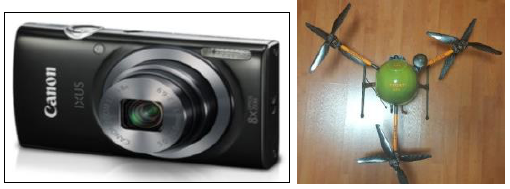
Figure 3. Air platform (hexacopter) and preferred sensor (Canon